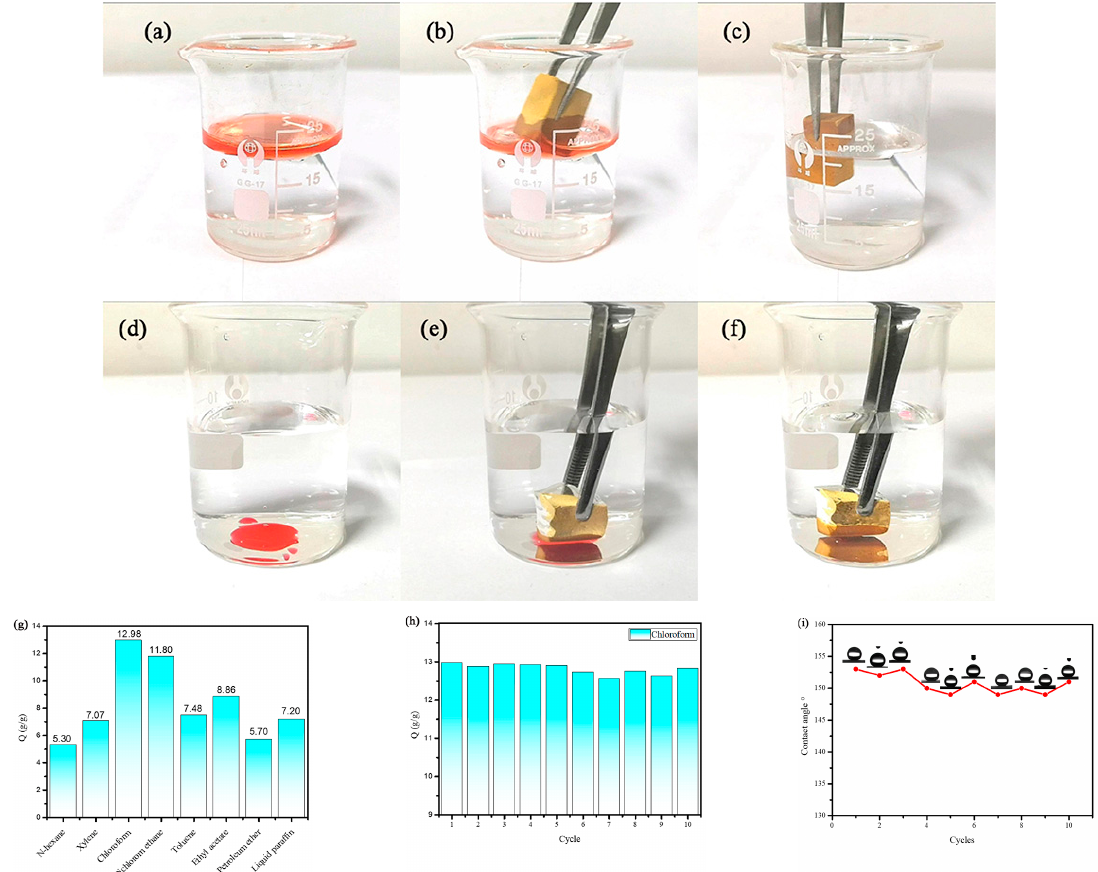
Figure 5. Water contact angle (WCA) of PF and ASO-PF: ( a ) WCA of PF xerogel surface, ( b ) WCA of ASO-PF xerogel surface, and ( c ) WCA of ASO-PF xerogel profile.